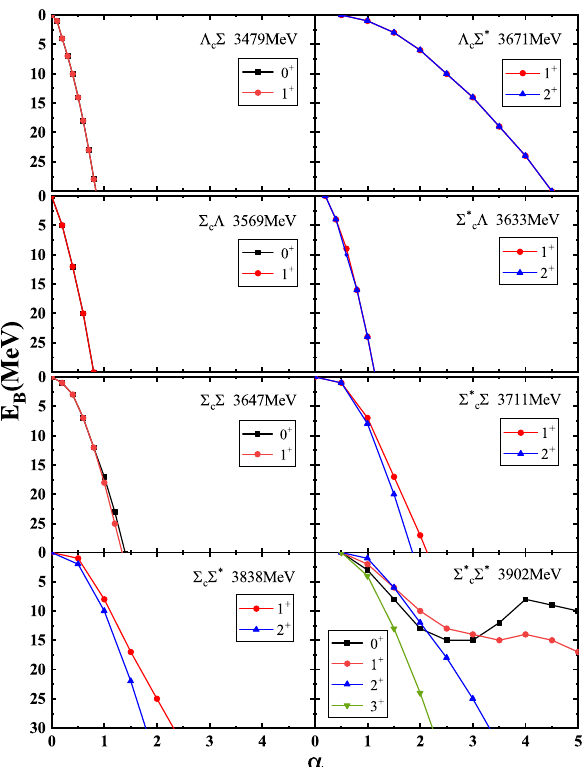
Fig. 2 Binding energies of isovector bound states from the charmed- strange interactionswiththevariationof α insingle-channel calculation